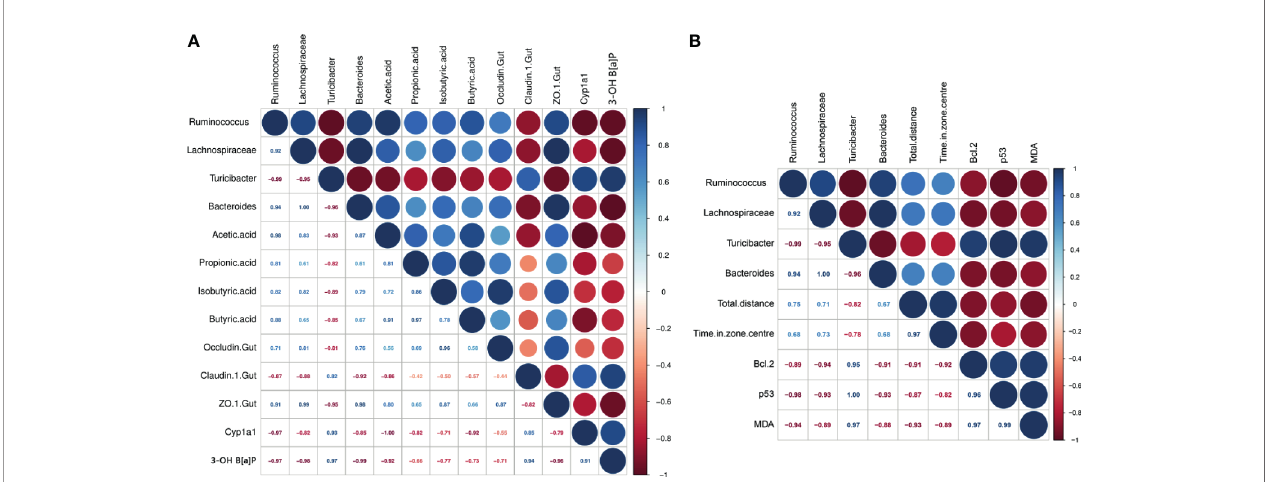
FIGURE 7 | Correlations between parameters signi fi cantly affected by B[a]P and L. plantarum CCFM8661 treatment. (A) The correlation of intestinal microbiota with gut-related parameters, (B) The correlation of intestinal microbiota with brain-related parameters. Signi fi cant negative and positive correlations are represented by red and blue circles,